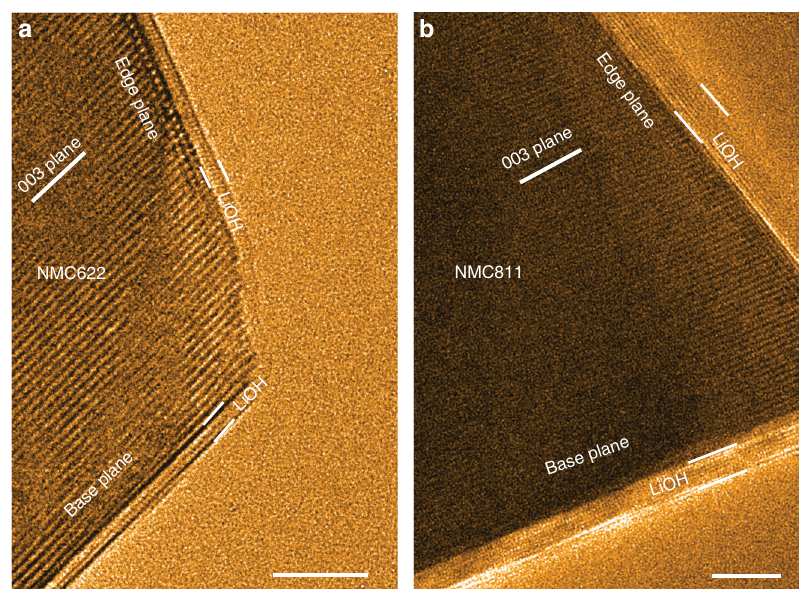
Fig. 3 Passivation layers on both the edge-plane and base-plane in NMC. The images are taken after exposing samples to H 2 O vapor (PH 2 O = 5 × 10 − 2 Torr) for 30 mins. a Surface of NMC622. b Surface of NMC811. Scale bar, 5 nm a , b .